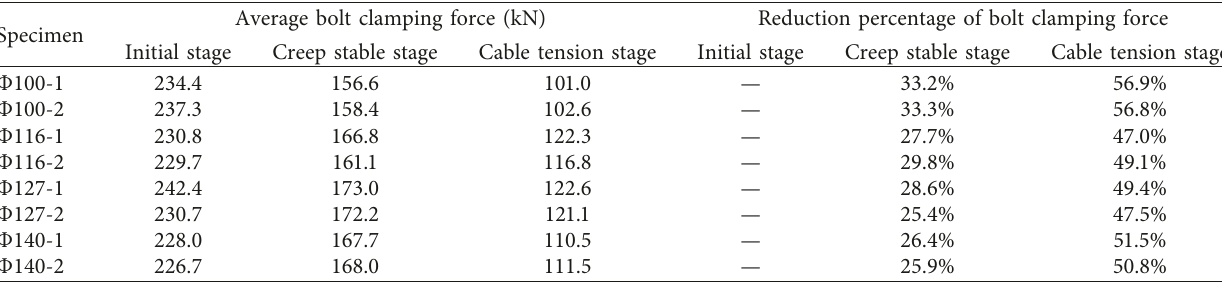
Table 5: Average bolt clamping force at different